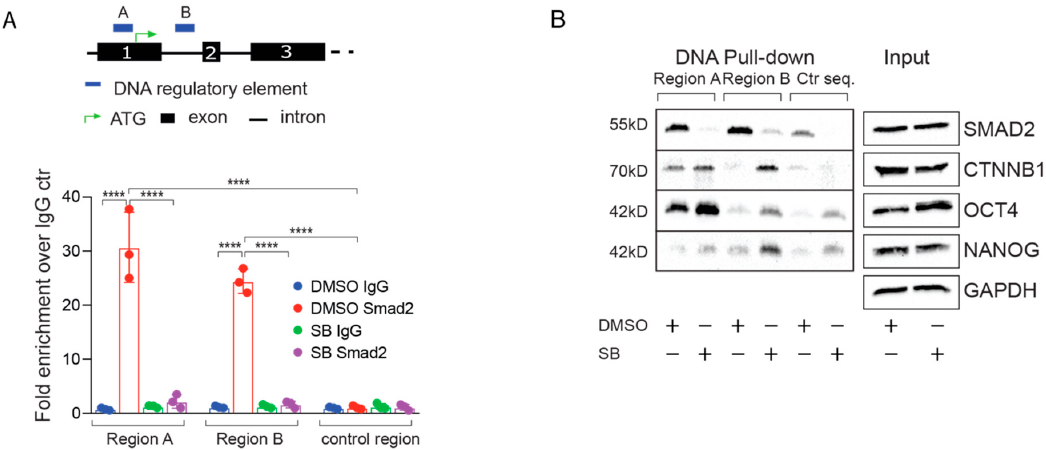
Figure 3. STOX2 is a direct target of TGF- β signaling. ( A ) Cartoon to illustrate the SMAD2 binding regions on the STOX2 gene (Upper panel). SMAD2 binds in an TGF- β dependent manner to DNA regulatory elements in the STOX 2 gene. ChIP-qPCR experiments showing fold enrichment of SMAD2 binding compared to IgG controls in region A, B and an upstream control region in the presence (DMSO) or absence (SB) of TGF- β signaling (illustrated below the bar graph). (N = 3, means ± SD, p - value **** p < 0.0001, 2-way ANOVA, Tukey’s multiple comparisons). ( B ) DNA pull-down assay with biotinylated probes coding for the two STOX2 regulons identified and a control sequence. hESCs (H1) were treated with 10 µM SB43152 for 2 h, total protein lysates obtained and incubated with the biotinylated DNA segments. After washing, the captured proteins were analyzed by immunoblot using antibodies as indicated. Equal loading was ensured by analyzing aliquots from the total protein lysates before pull-down by immunoblot. Representative blots of three independent experiments are